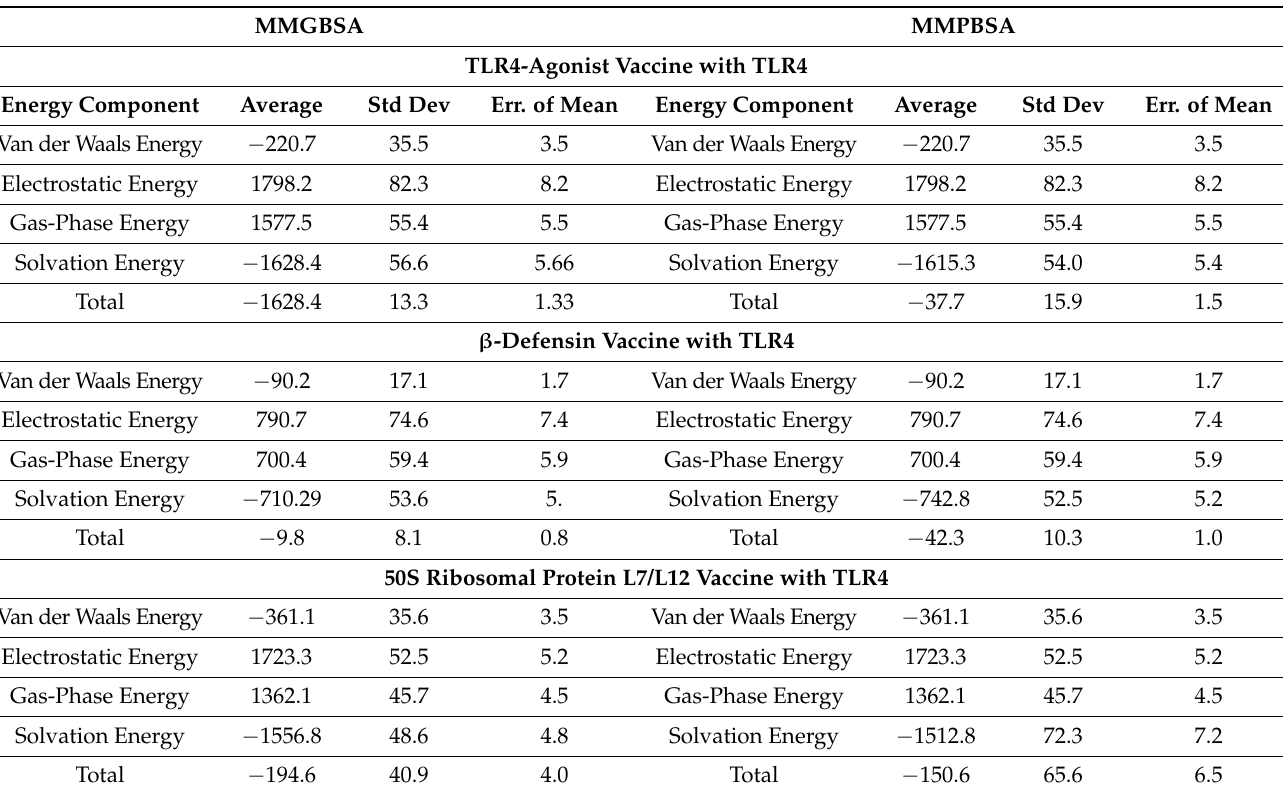
Table 4. Binding free energies estimated for complexes. The values are given in kcal/mol. MMGBSA MMPBSA TLR4-Agonist Vaccine with TLR4 Err. of Mean Energy Component Average Err. of